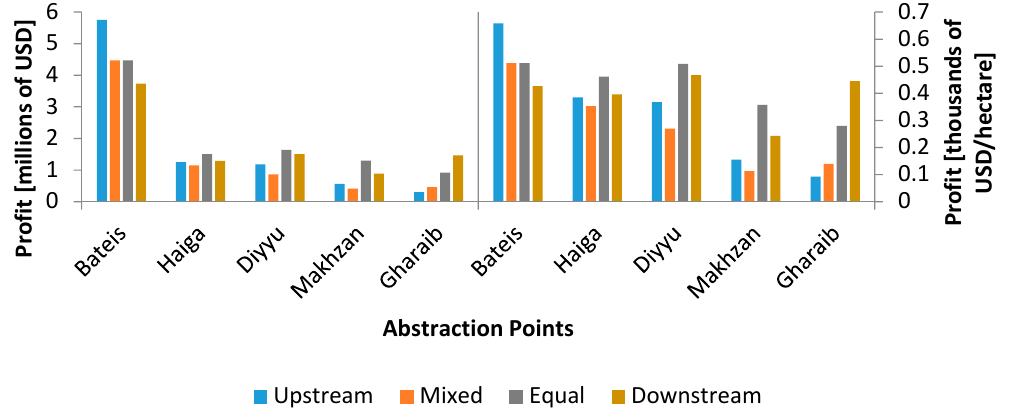
Figure 5. Expected annual profit for areas served by each weir per water allocation scenario.